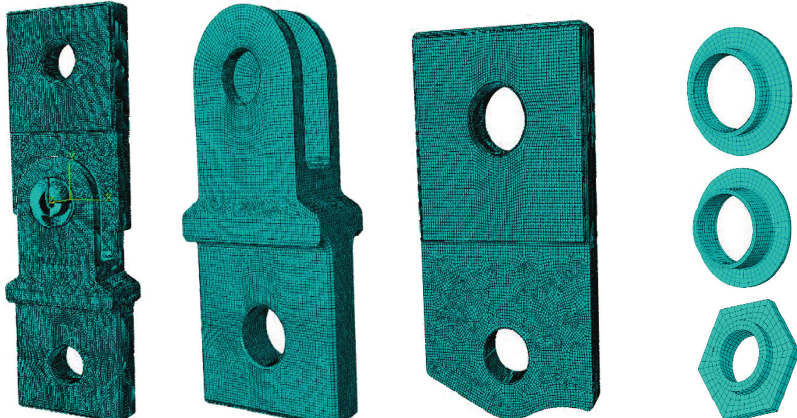
Figure 15: Model of emergency fuse pin and